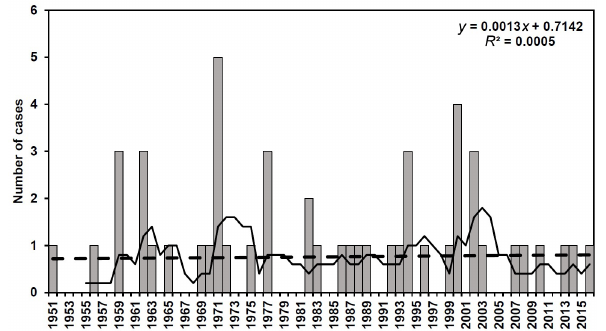
Figure 6. Temporal evolution of the annual frequency of ex- treme torrential events ( ≥ 200mm in 24h) throughout the 1951– 2016 study period. The figure shows the linear regression (dashed line) and 5-year running mean (black